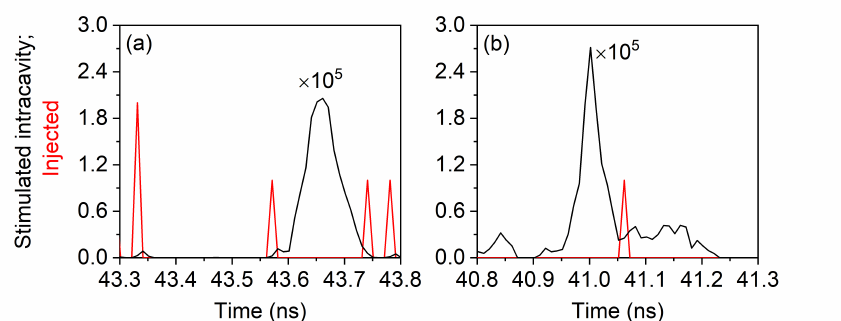
Figure 5. Temporal superposition of intracavity pulse generation (black line) and reinjection of stimulated photons from a previous pulse (red line). ( a ) The injected photon takes place at the beginning of the black pulse (a second one is coupled into the cavity at the end); ( b ) the injected photon intervenes in the middle of the pulse (in time, but late in terms of photon fraction). Notice that the scales for the two kinds of curves differ by five orders of magnitude. This example is taken for the lowest value of η considered; thus, the reinjection consists mostly of one photon at a time. For η = 0.1, pulses with up to nine photons are observed (with small likelihood), but their number remains small compared to the intracavity photon